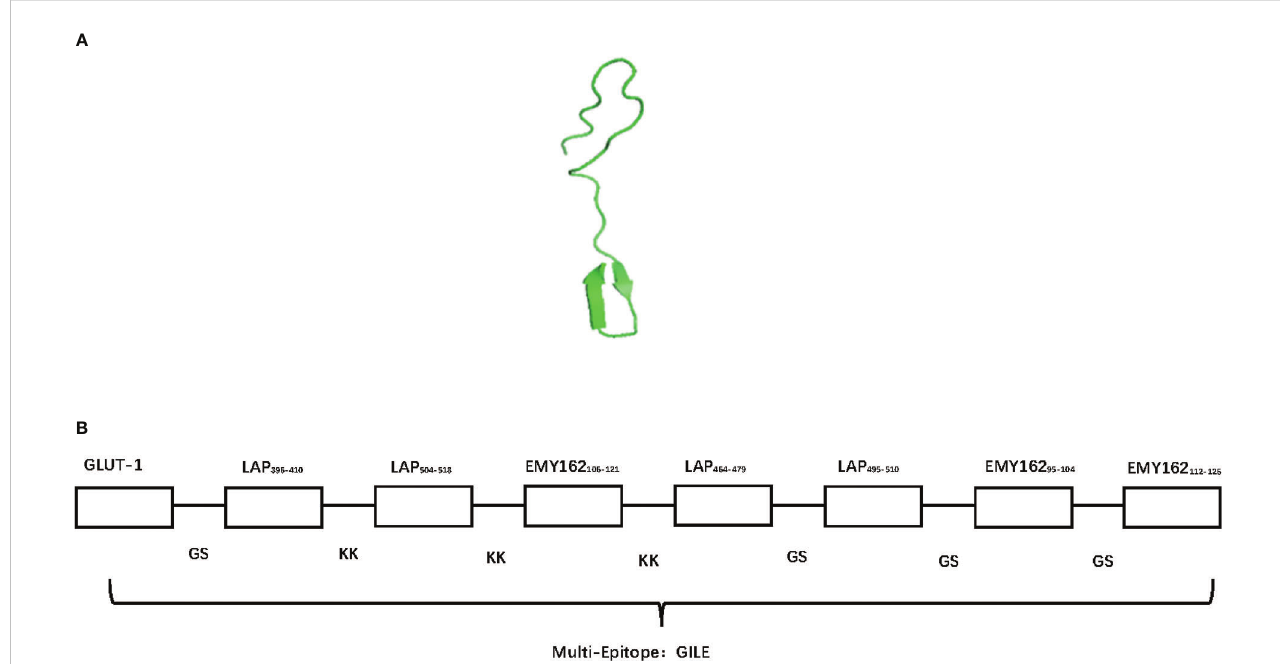
FIGURE 1 The bioinformatics construction of GILE results. (A) : The different homological models of GILE 3D construction of simulation by SWISS-MODEL; (B) : The order of epitopes in construction of GILE, signal T cell epitopes link by KK (Lysine- Lysine), signal B cell epitopes link by GS